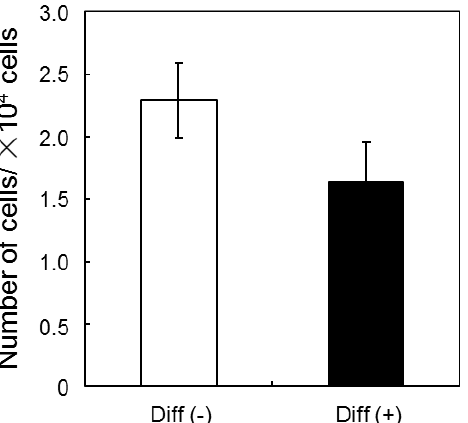
Figure 2. Number of cells in 3D silica fibers cultured in normal medium (Diff (−)) and chondrogenic differentiation medium (Diff (+)) for 4 weeks after seeding at a density of 3.0 × 10 5 cells/well and preculturing for 1 week.